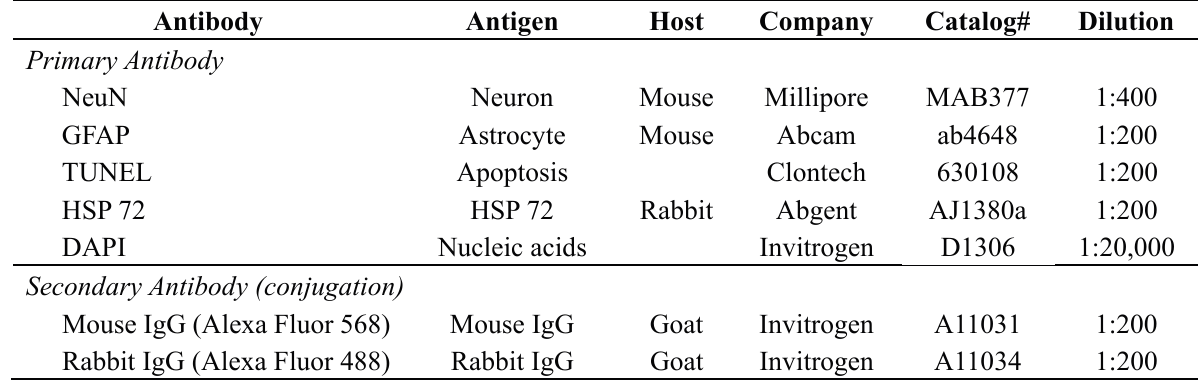
Table 2. Immunofluorescent staining in a spinal cord injury rat